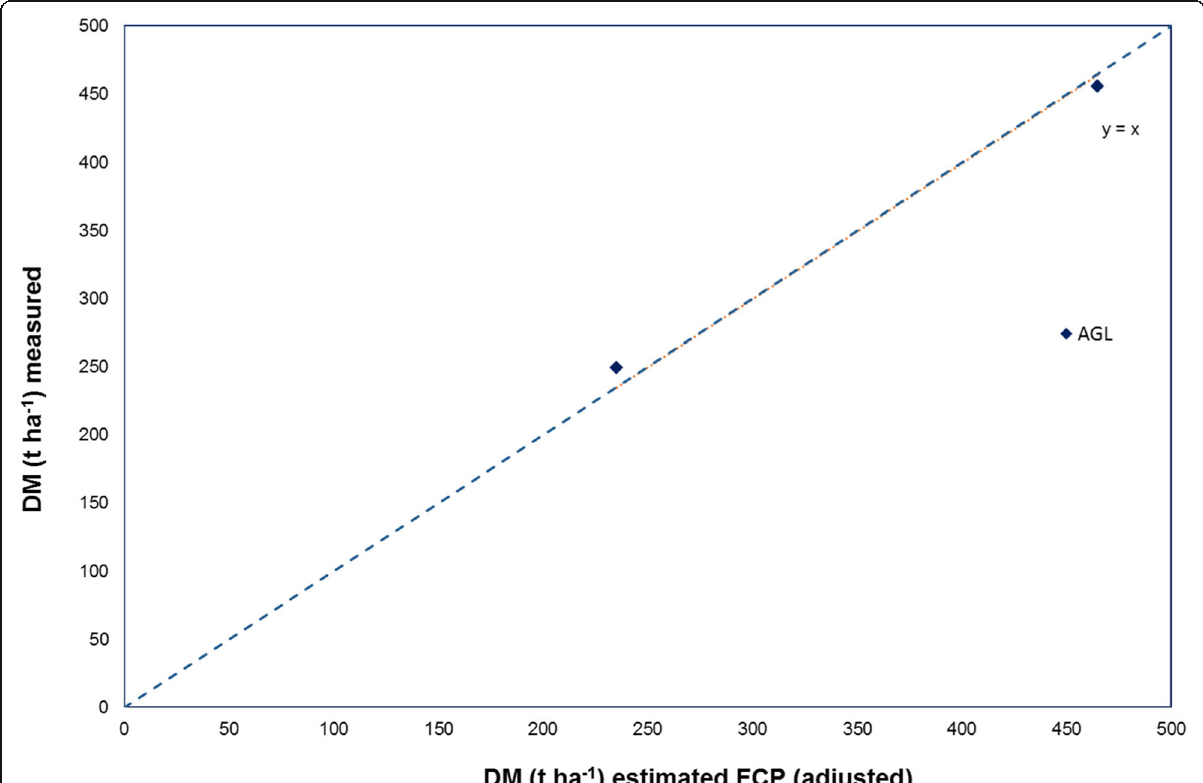
Fig. 6 Relationship between measured crown and stem dry matter (DM) in Cupressus lusitanica stands and adjusted predictions using the Forest Carbon Predictor